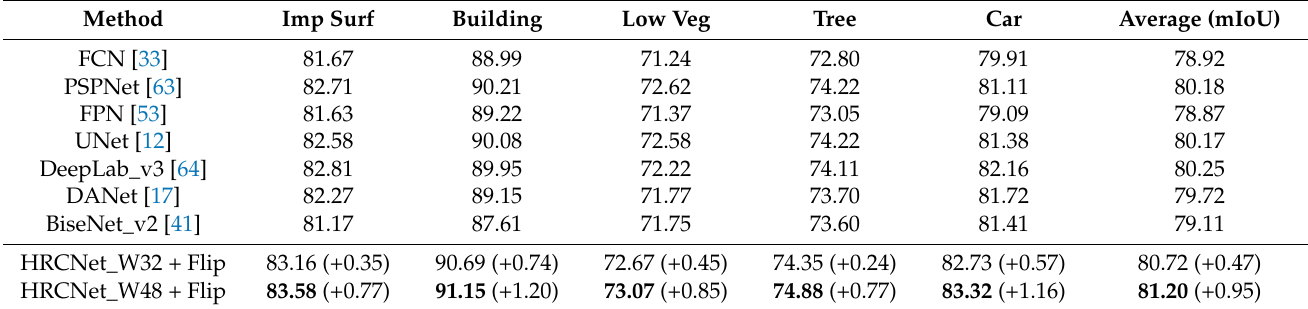
Table 6. IoU scores (%) of each category on the Potsdam